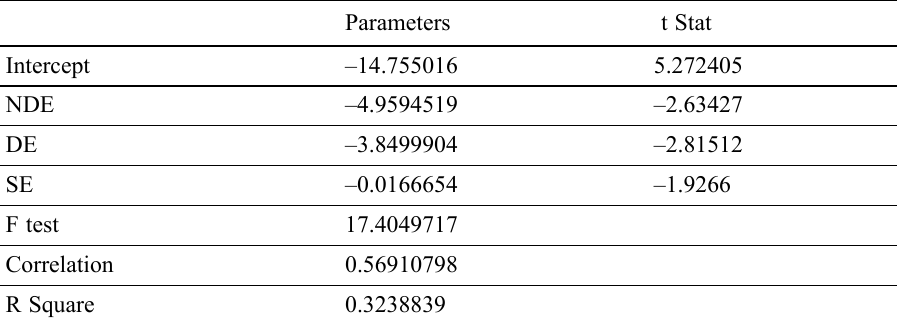
Table 2. Statistical Description of ROE